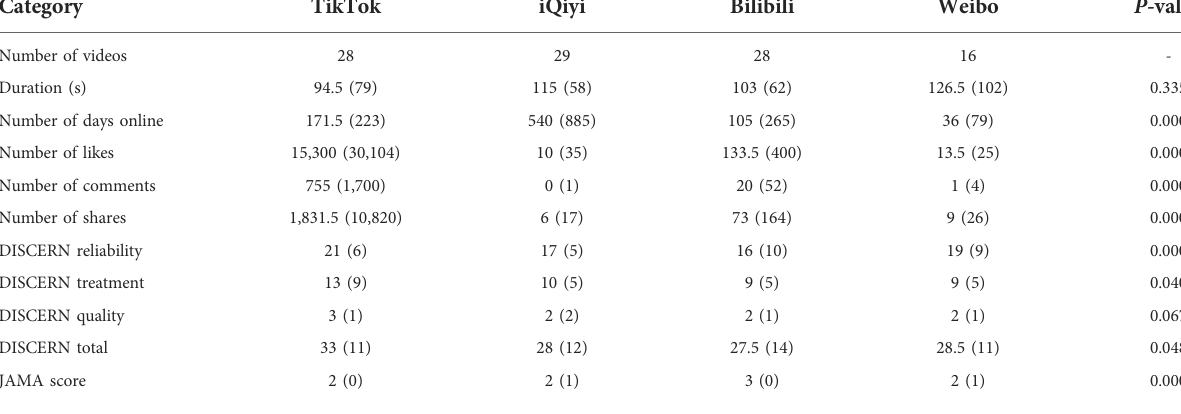
TABLE 4 DISCERN classi fi cation data of the understudied